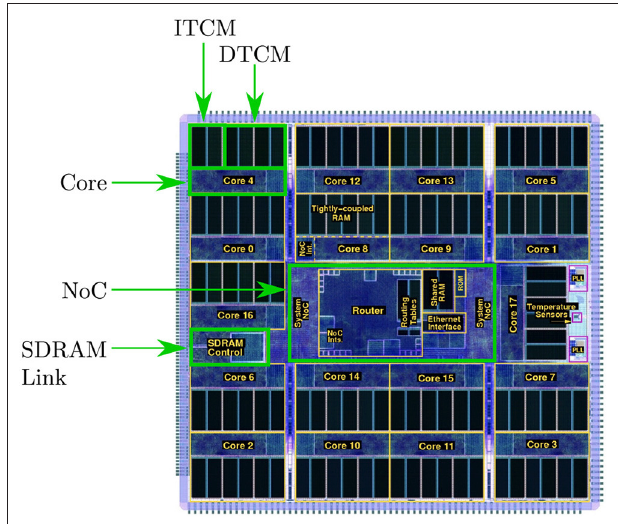
FIGURE 1 | The SpiNNaker Chip, containing: 18 cores, each with local instruction and data memory; network on chip; and SDRAM controller providing access to 128MB of chip-level shared